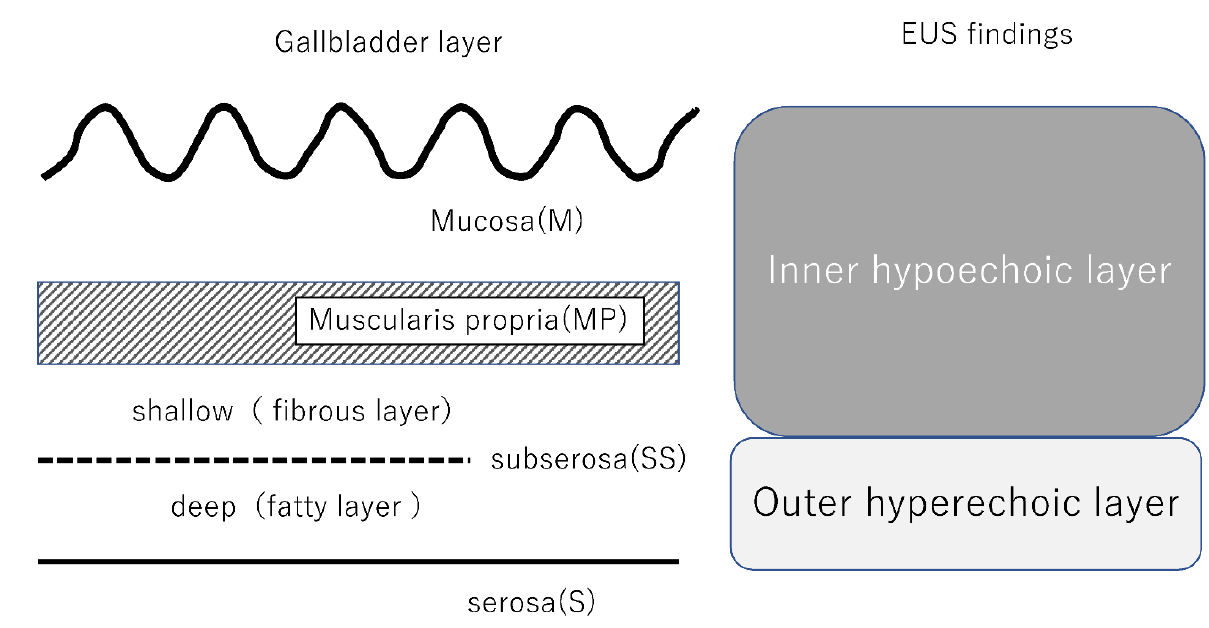
Figure 6. Comparison of gallbladder layer and EUS findings.